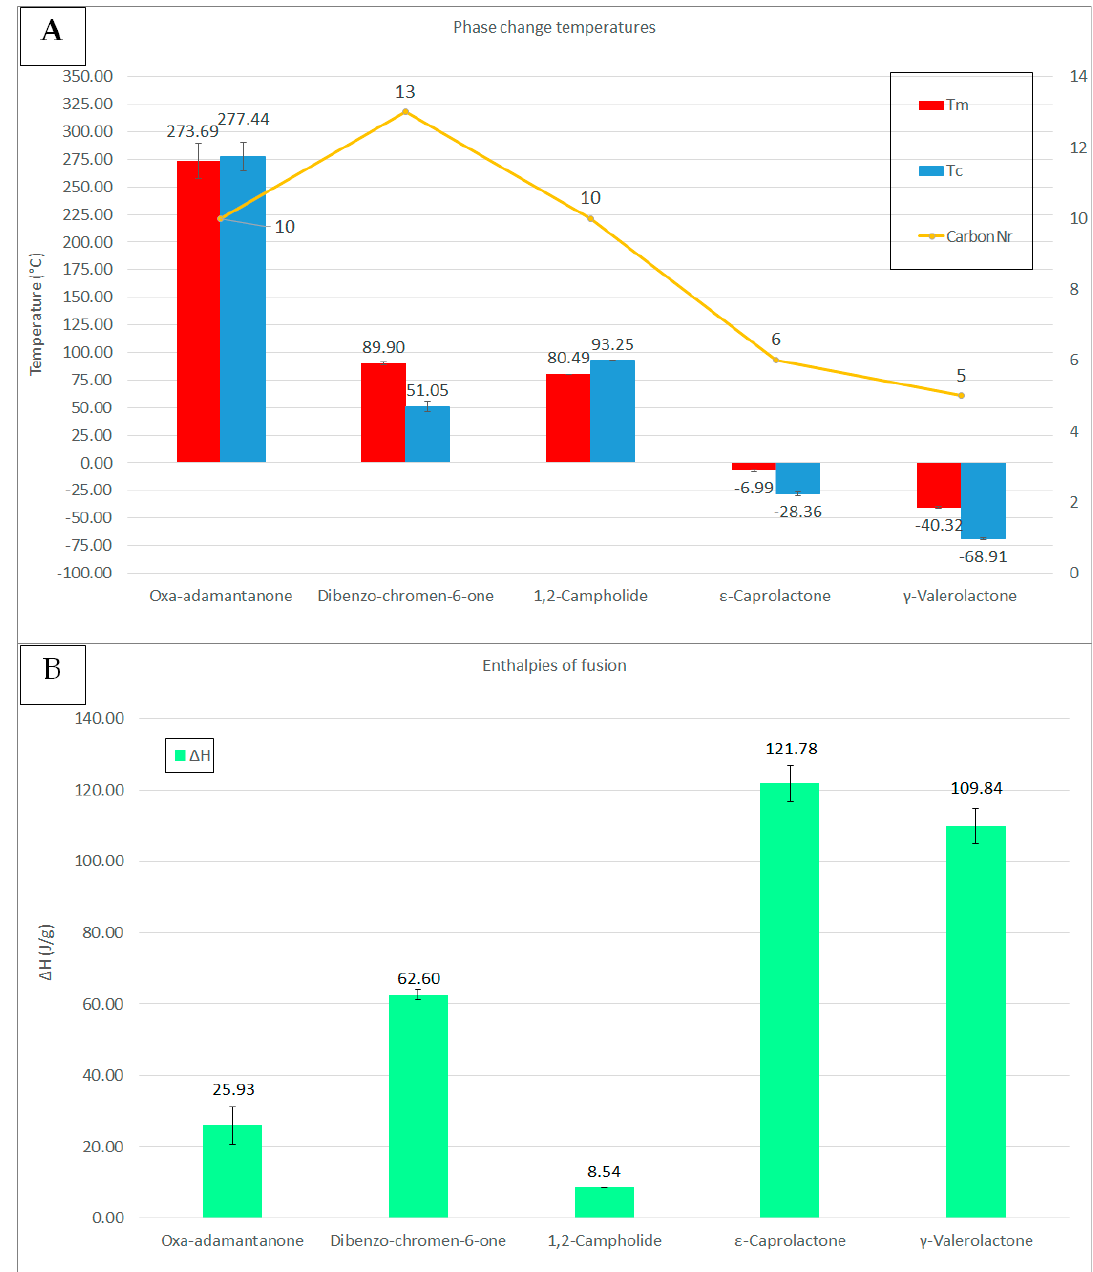
Figure 3. ( A ) Melting (red bars, Tm) and crystallization (blue bars, Tc) onset phase change temperatures in °C measured for both the commercial and synthesized lactones reported in this study. The carbon number of each lactone (yellow line) is showed to observe possible trends correlating the chemical structure to the phase change transitions. In general, no clear correlation between the carbon number and phase change temperatures was noticed. In the case of 1,2-campholide, no error bars could be reported due to inconsistent crystallization. ( B ) Enthalpies of fusion in J/g (green bars, Δ H) for the lactones described previously. Analogously to what explained above, the error bars for 1,2-campholide’s enthalpy could not be calculated. All synthesized lactones show enthalpies of fusion ≤ 70 J/g while commercial ones are above 100 J/g. Oxa-adamantanone’s enthalpy has a higher standard deviation due to the phase change occurring in the same temperature range as the thermal degradation, thus causing the enthalpy to greatly decrease after each heating-cooling